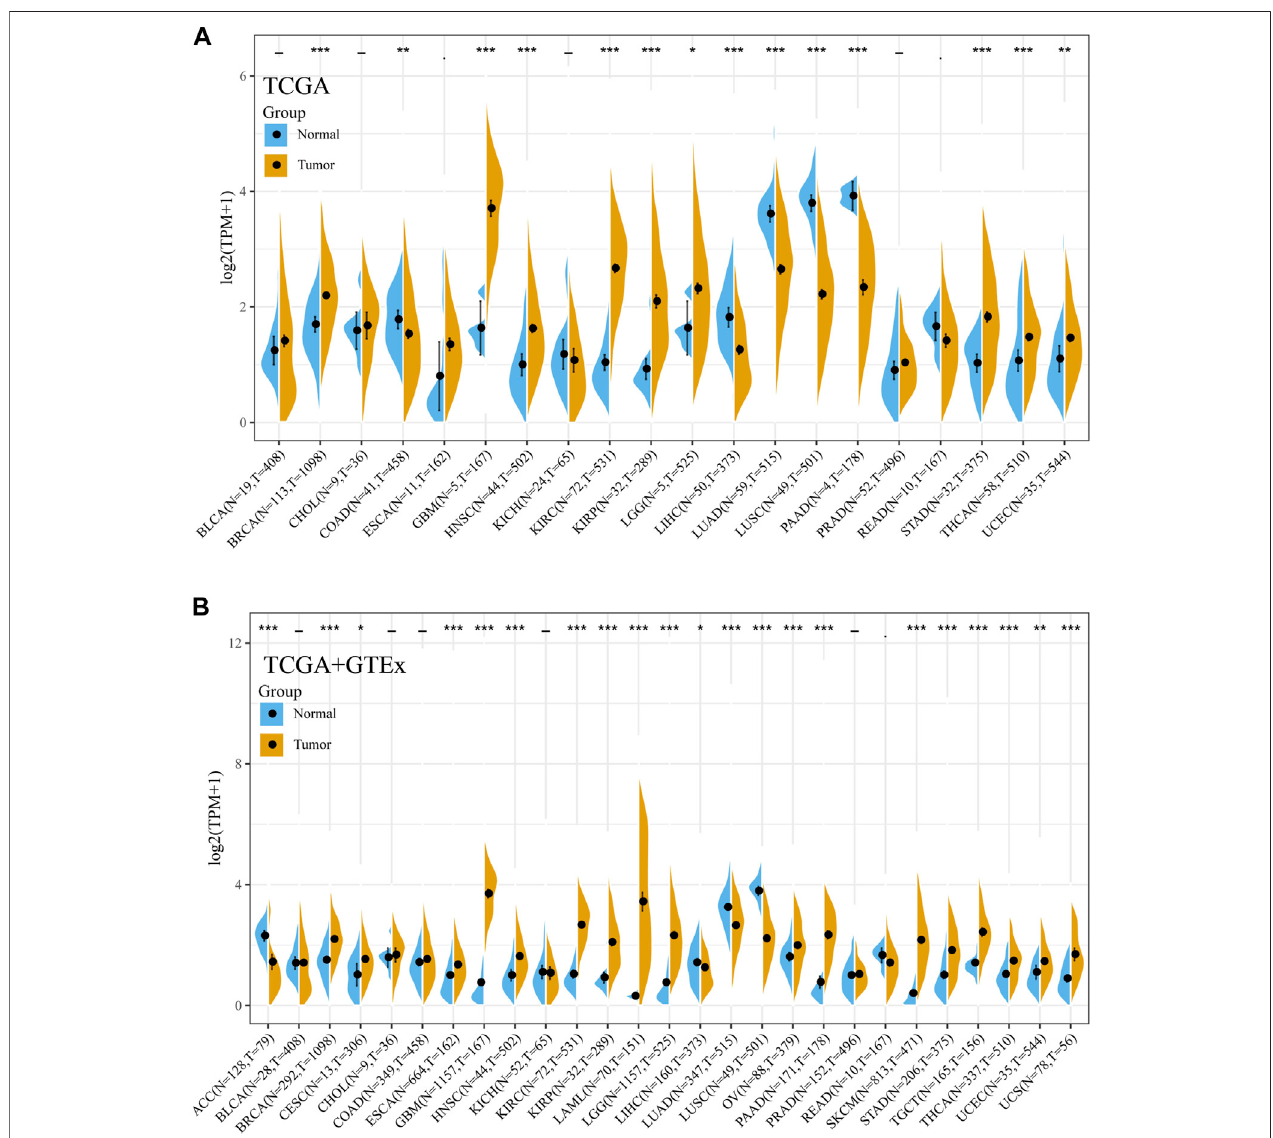
FIGURE 1 | The mRNA expression of Siglec-9 in various cancers according to The Cancer Genome Atlas (TCGA) and Genotype-Tissue Expression (GTEx). (A) Siglec-9 expression in pan-cancer relied on TCGA. (B) Sigelc-9 expression in pan-cancers based on TCGA and the normal samples were enriched with the GTEx database. ( t -test, p < 0.05 was considered to be signi fi cant, * p < 0.05, ** p < 0.01, *** p < 0.001. N: Normal tissue; T: Tumor tissue.)